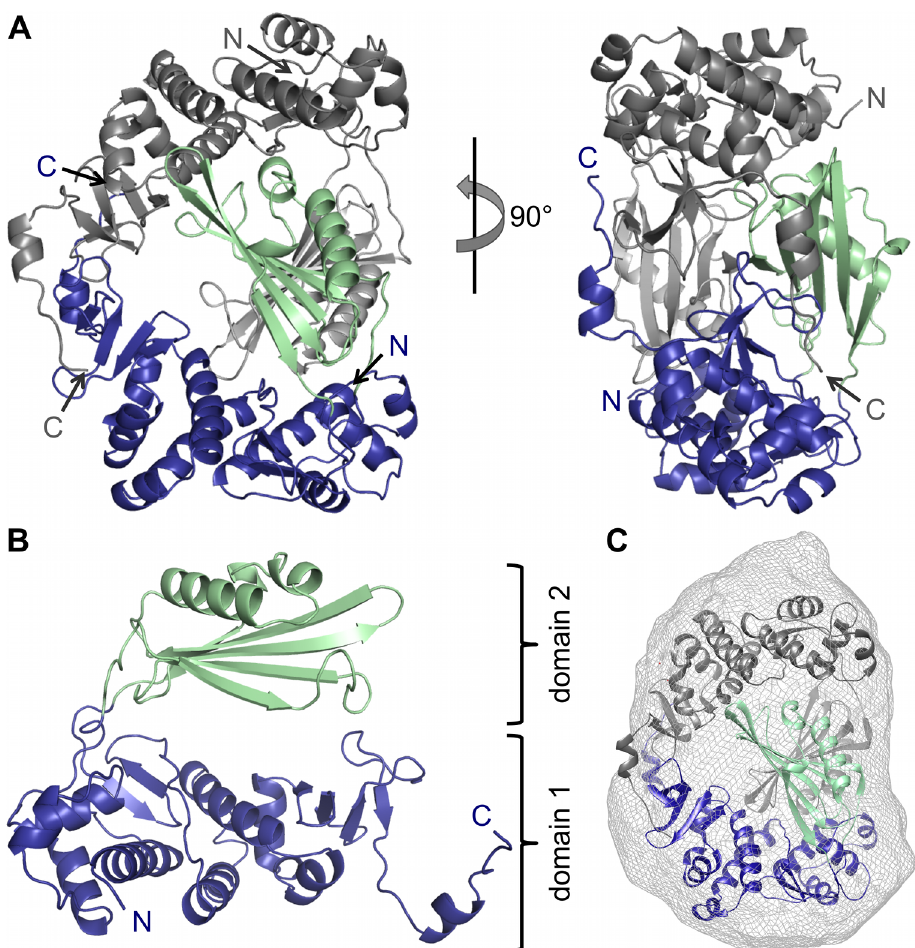
Fig 1. Atomic structure of CASV L-Cterm. A) The structure of the protein dimer in the asymmetric unit is shown as a ribbondiagram in front and side view. Chain A is coloredin blue and green, chain B is coloredin dark and light grey. N- and C-terminiare labelled. B) Chain A is shown as a ribbondiagram. N- and C-termini are labelled.Domain1 is shown in blue, domain 2 in green. C) Superimposition of SAXS-derived molecular shapewith the crystal structure (ribbondiagram)confirms the dimeric conformation of the protein at 1 mg/ml in solution.